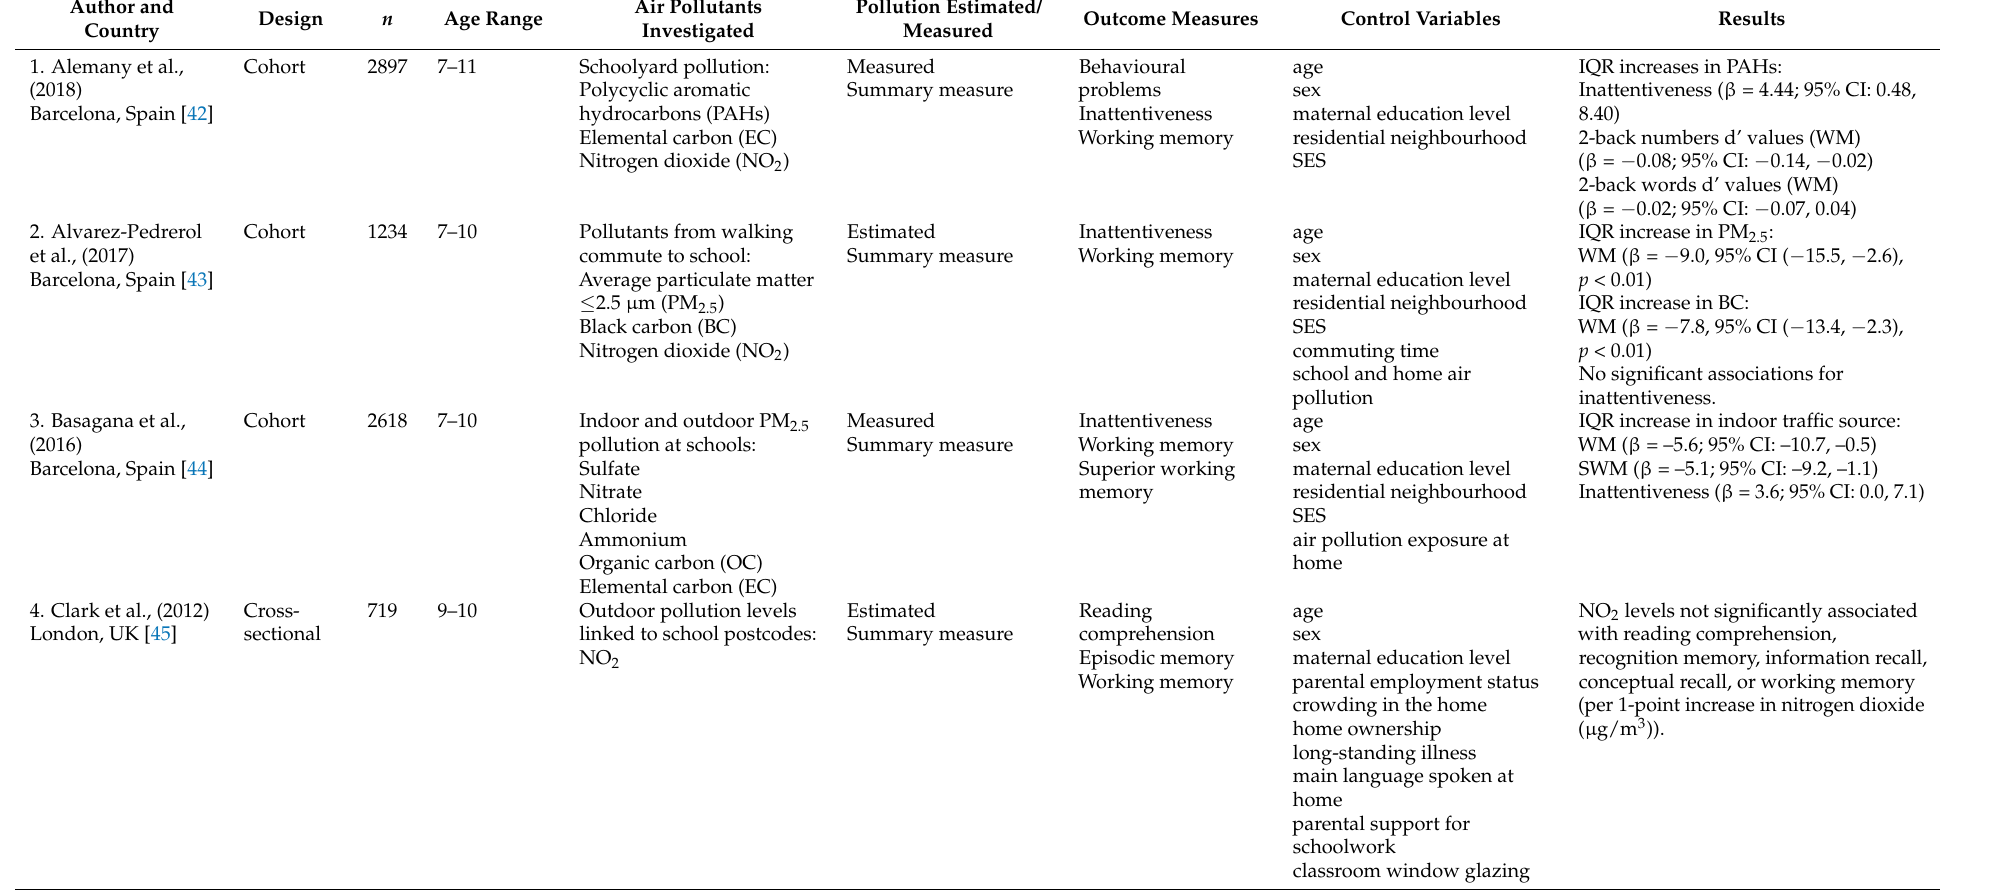
Table 1. Characteristics of reviewed